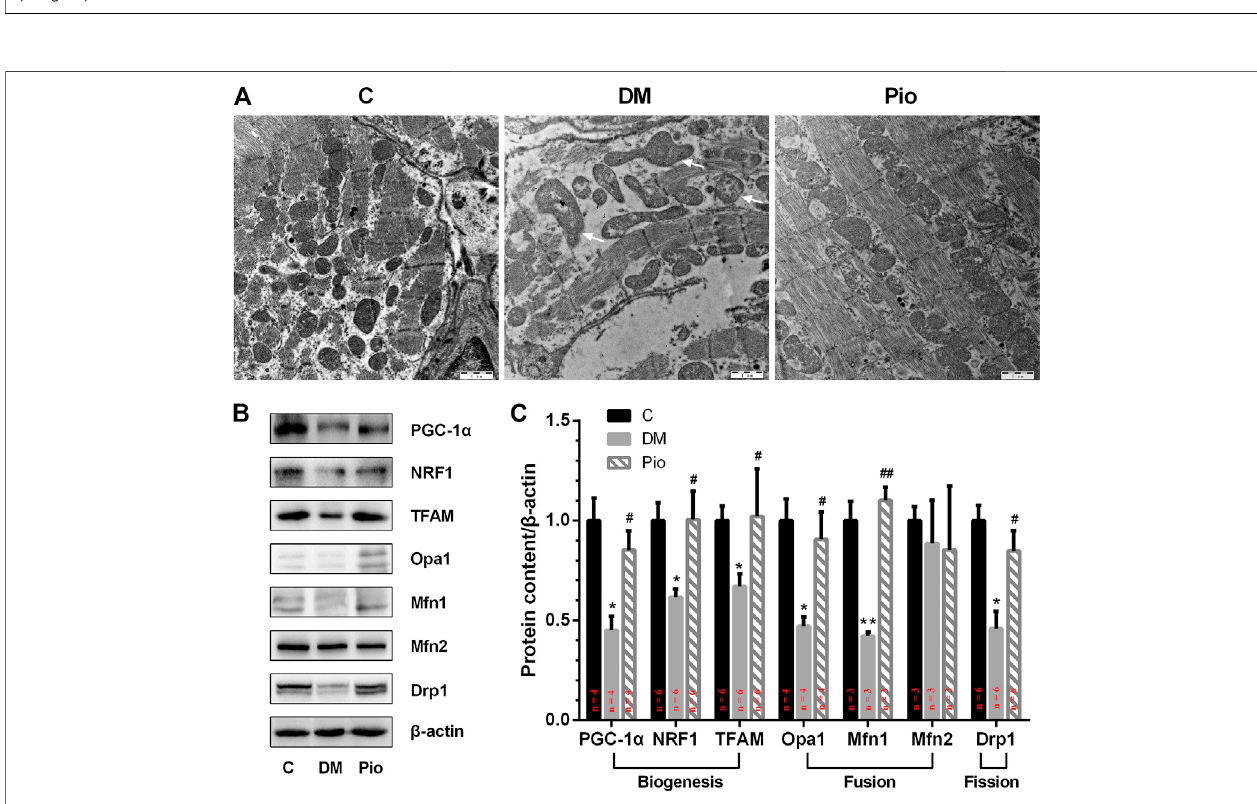
FIGURE 5 | Pioglitazone improved diabetes-induced mitochondrial network damage and the dynamic balance between mitochondrial fusion and fi ssion. (A) Comparisonofleftatrialultrastructureamongthethreegroups.Diabeticrabbitspresentseverelydisintegratedmyo fi lamentsandswellingofmitochondria,accompanied by fractured cristae (arrows), which could be ameliorated by pioglitazone treatment. (B) Expression of proteins involved in mitochondrial biogenesis, fusion, and fi ssion assessed by Western blotting analysis. (C) Quanti fi cations of protein expression of (B) . Values are presented as mean ± SEM. *Compared with the C group, p < 0.05; **compared with the C group, p < 0.01; #compared with the Diabetic group, p < 0.05; ##compared with the Diabetic group, p < 0.01. n (cid:2) 3 – 6 per group.